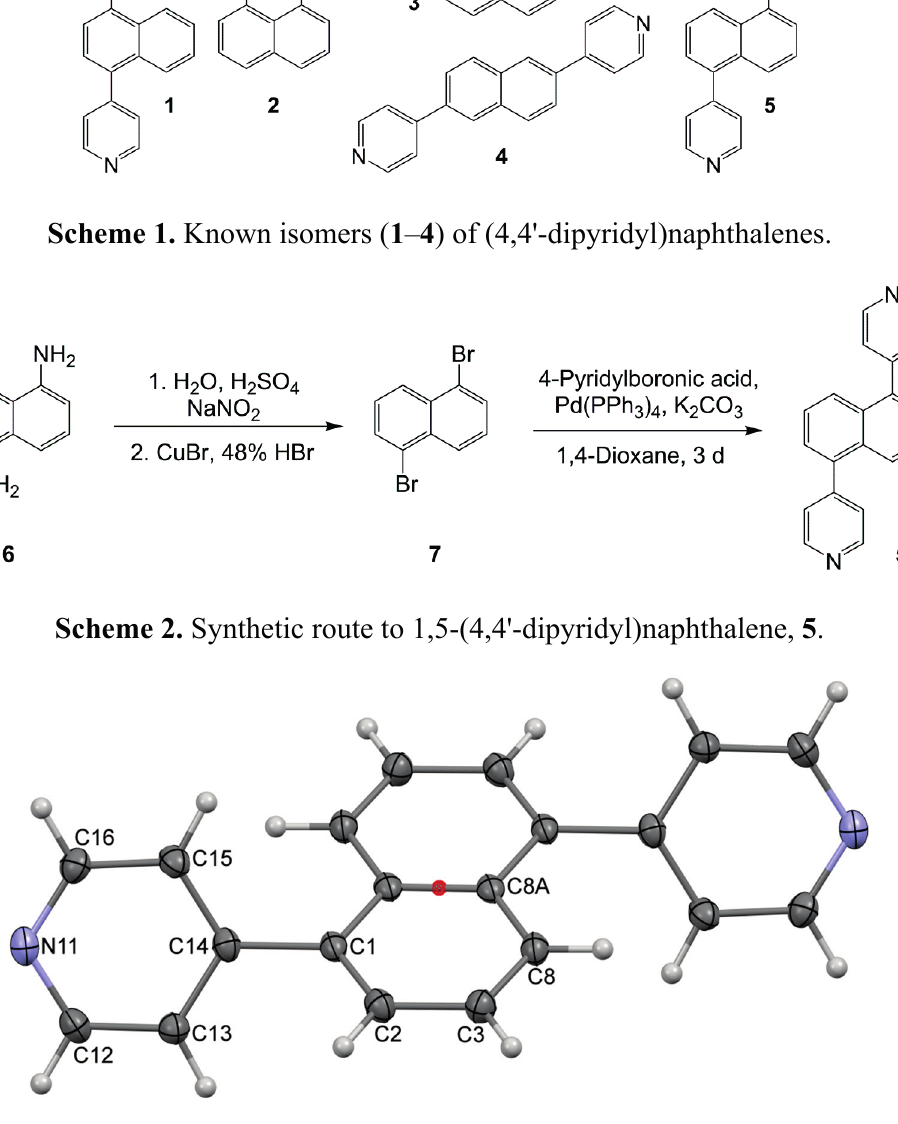
Figure 1. Displacement ellipsoids plot (40% probability) of the structure of 5 as found in the crystal; the crystallographic centre of symmetry is indicated as a red dot. Selected bond lengths [Å] and bond angles [°]: N11–C12 1.340(2); N11–C16 1.3365(19);